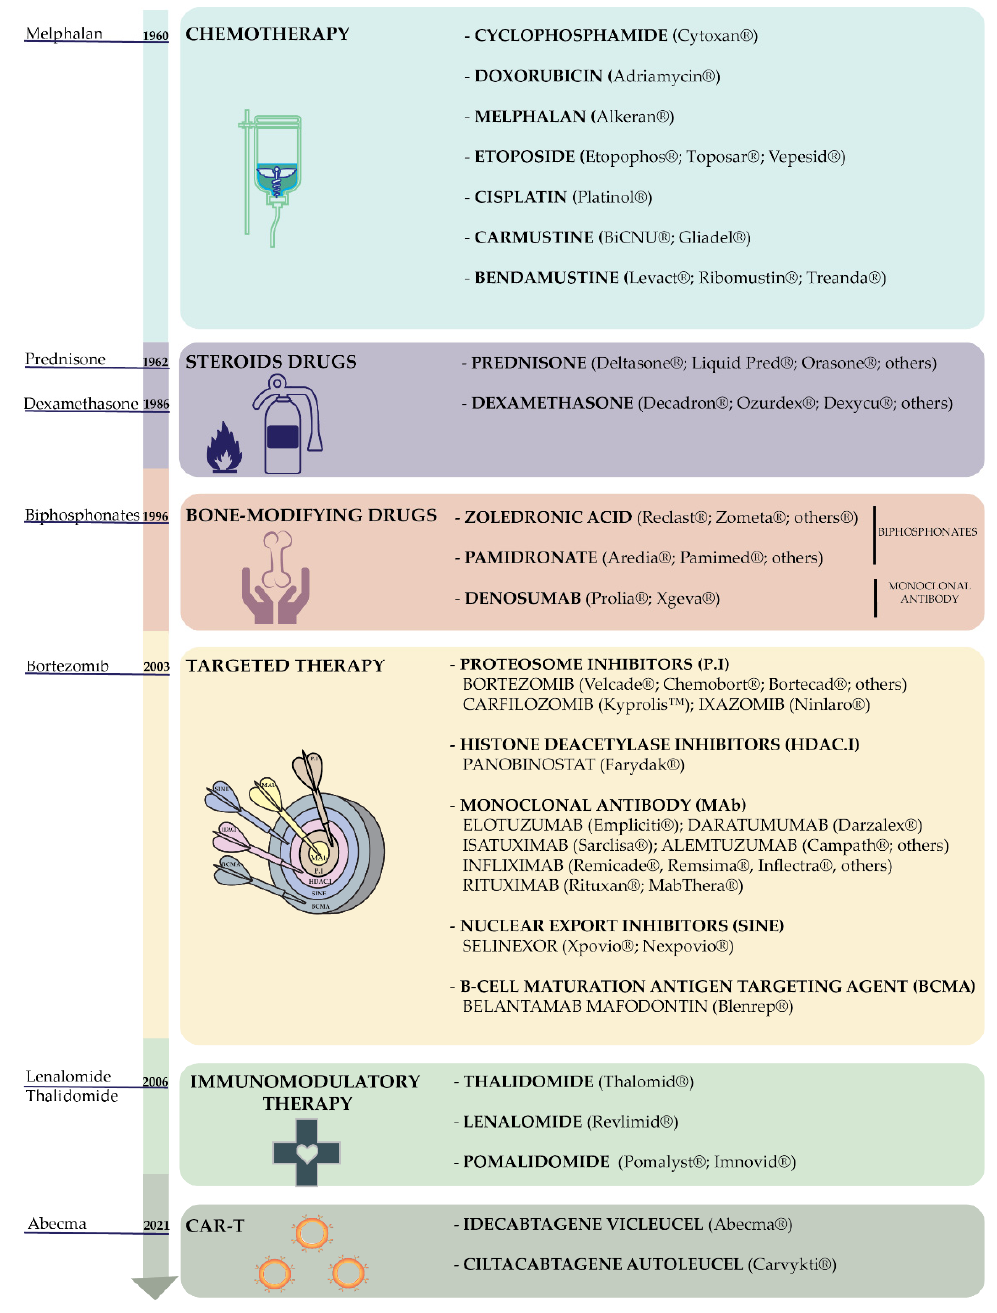
Figure 2. Schematic representation and positioning of pioneering drugs for treating multiple myeloma over the years (arrow). For each typology of drugs, the most representative compounds with their corresponding commercial names are reported in the specific boxes.